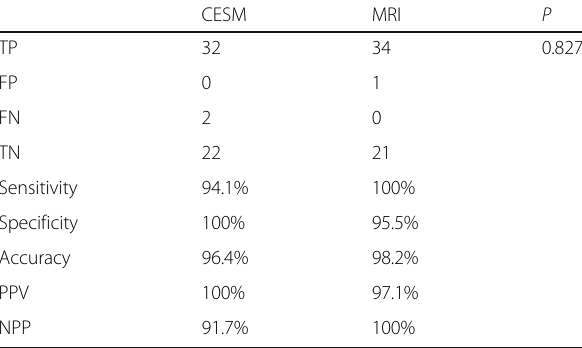
Table 5 Represented the sensitivity, specificity, accuracy, PPV and NPV CESM